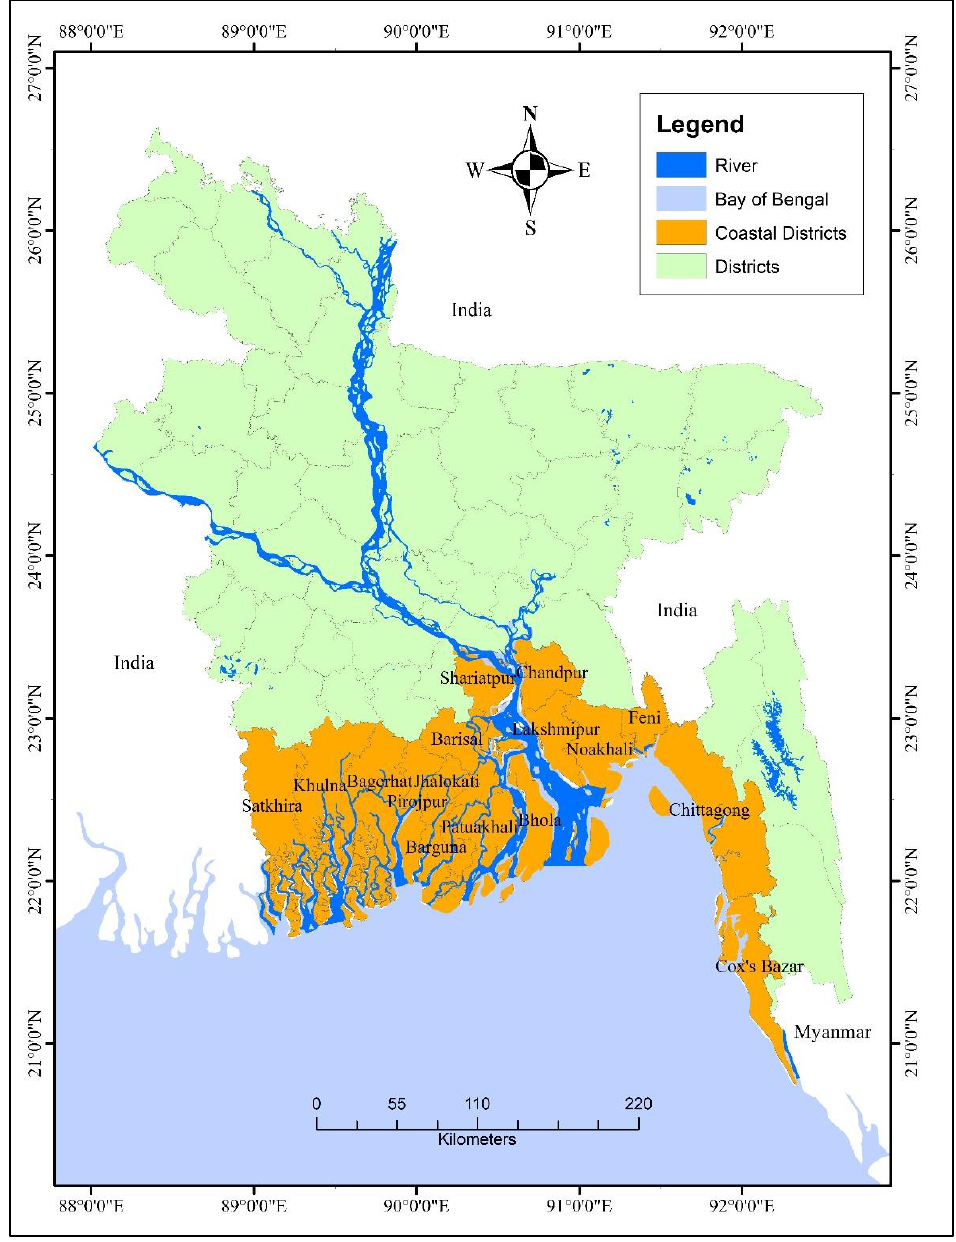
Figure 2. Map of coastal areas of Bangladesh (Source: Authors, 2023).